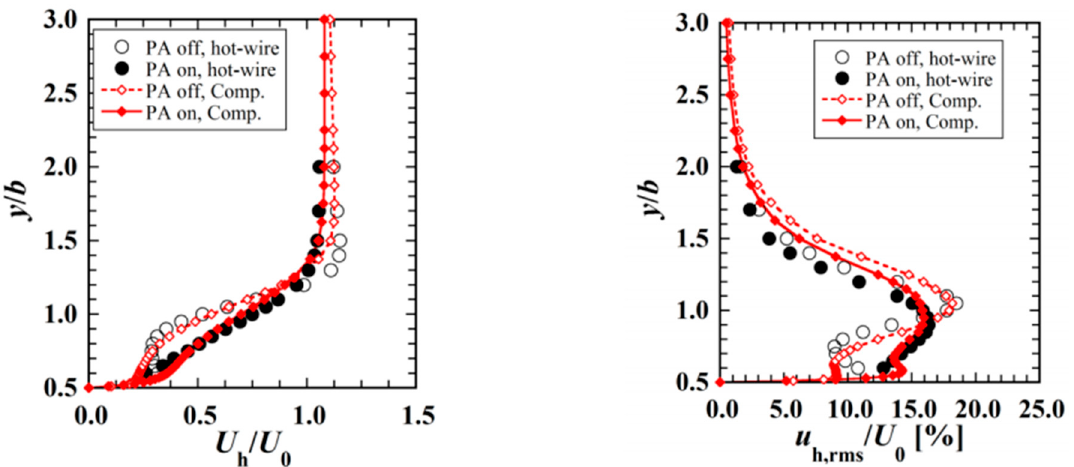
Figure 11. Measured and predicted profiles of mean streamwise velocity U h at the downstream position from the leading edge with the distance of 4.5 b from the leading edge are shown in the left figure, where y / b = 0.5 is corresponding to position of plate wall. The right figure shows the profiles of turbulent intensity. These figures show both the predicted profiles agree with those measured for the cases with and without control by the plasma actuator [31].